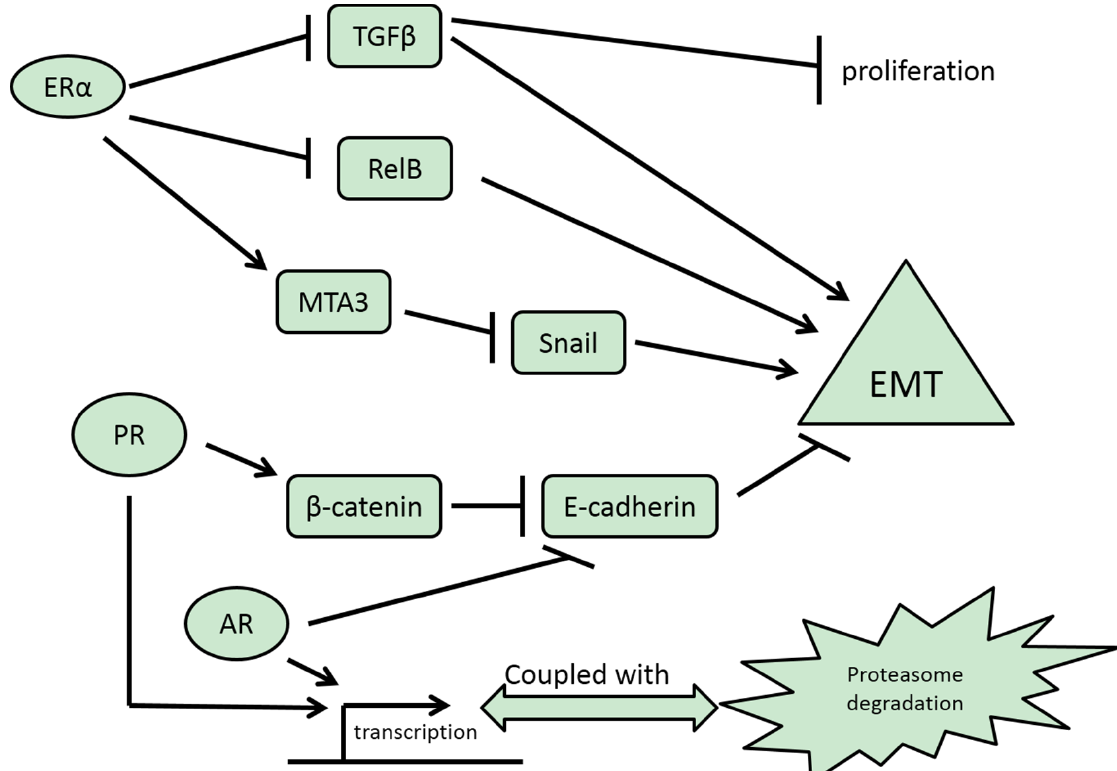
Figure 1. Pathways leading to EMT regulation by SNRs ER α , PR and AR. Transcriptional activity affecting EMT may be coupled with proteasome recycling, and thus the relationship of EMT regulation and receptor expression may not be straightforward. Arrows denote activation and reverse T signs denote inhibition.